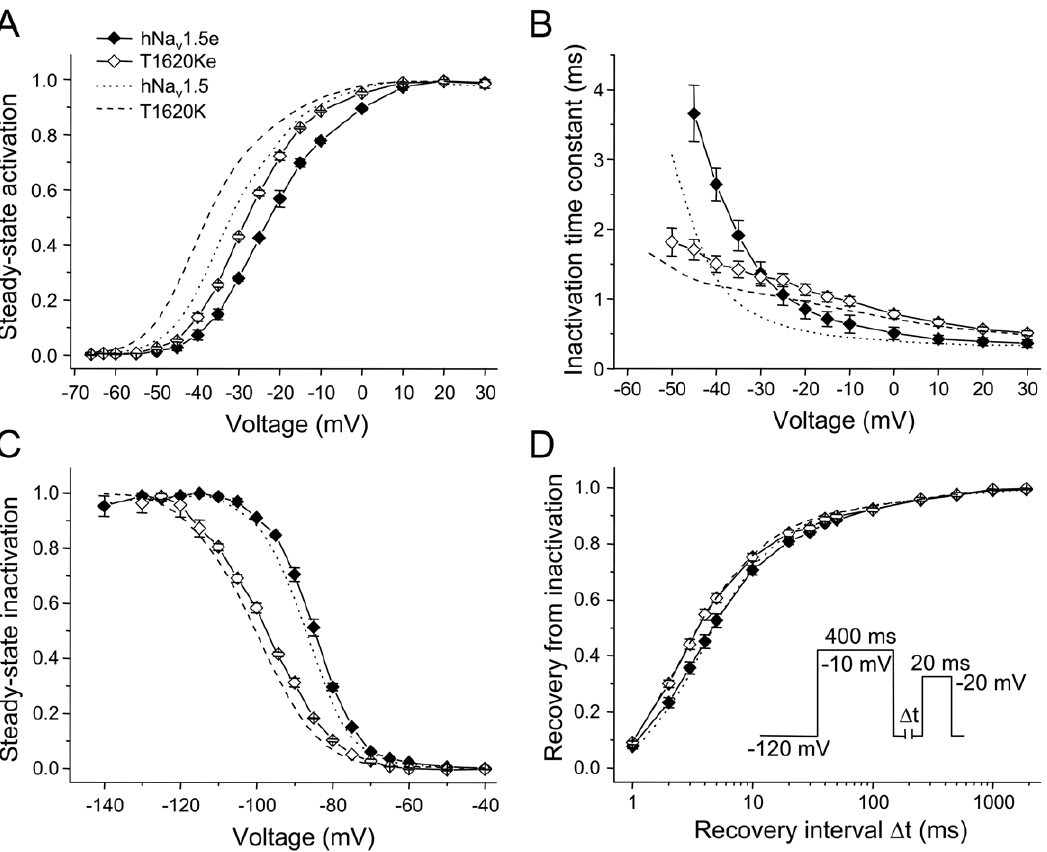
Figure 6. Electrophysiological properties of spliced hNa v 1.5e and T1620Ke channels. Steady-state activation (A), time constants of inactivation (B), steady-state inactivation (C) and recovery from inactivation (D). In the neonatal variant hNa v 1.5e, the mid-activation potential was shifted towards depolarized potentials, similarly as found for splice variant hNa v 1.5d. Mutation T1620K caused a hyperpolarized shift of the steady-state activation.